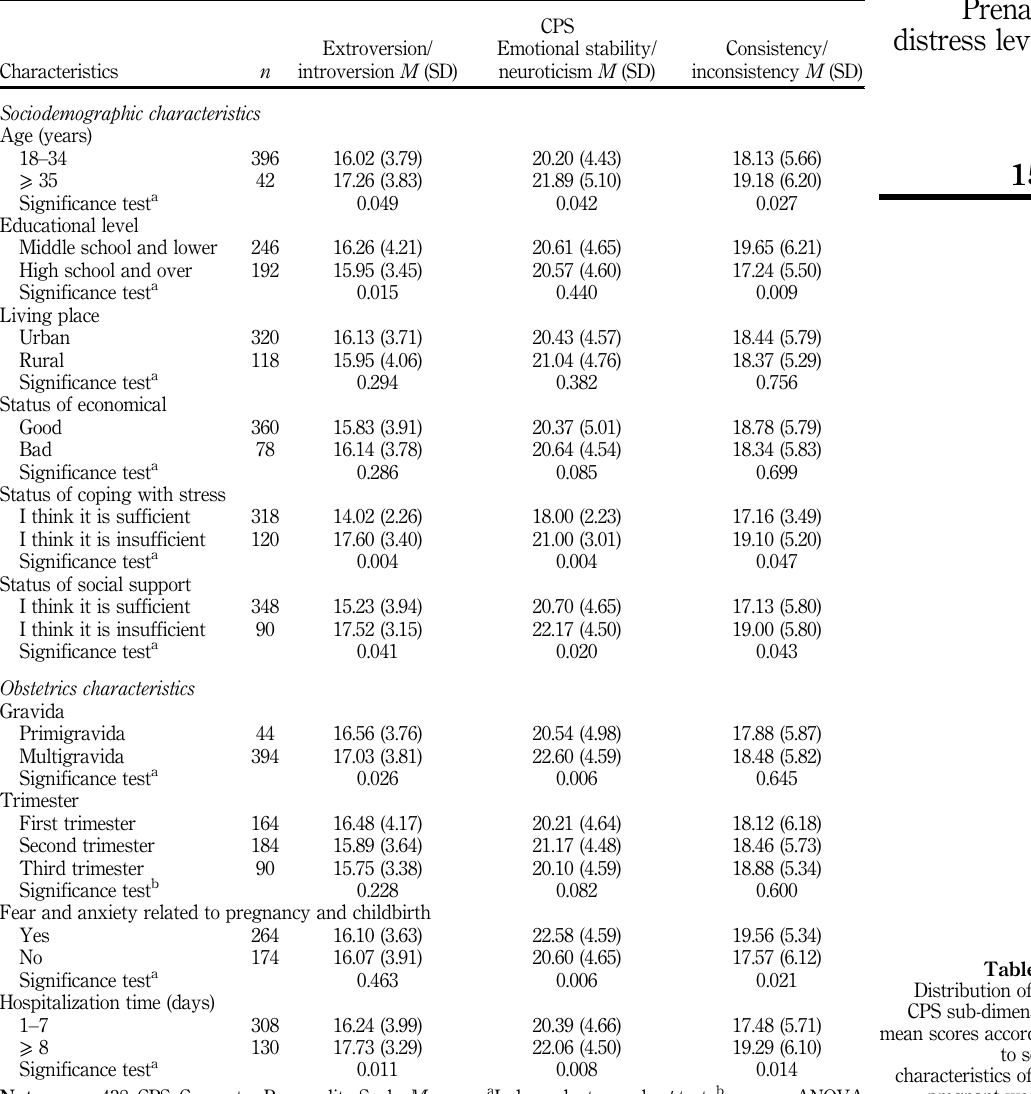
Table V. Distribution of the CPS sub-dimension mean scores according to some characteristics of